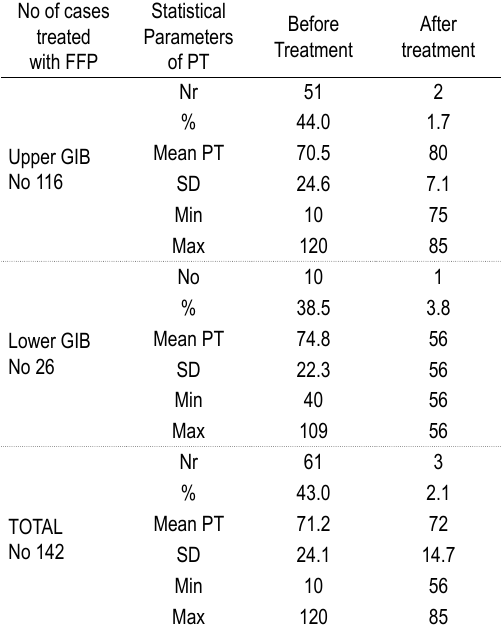
Table 9. values of Pt before and after application of fresh frozen Plasma in patients with Gastro intestinal